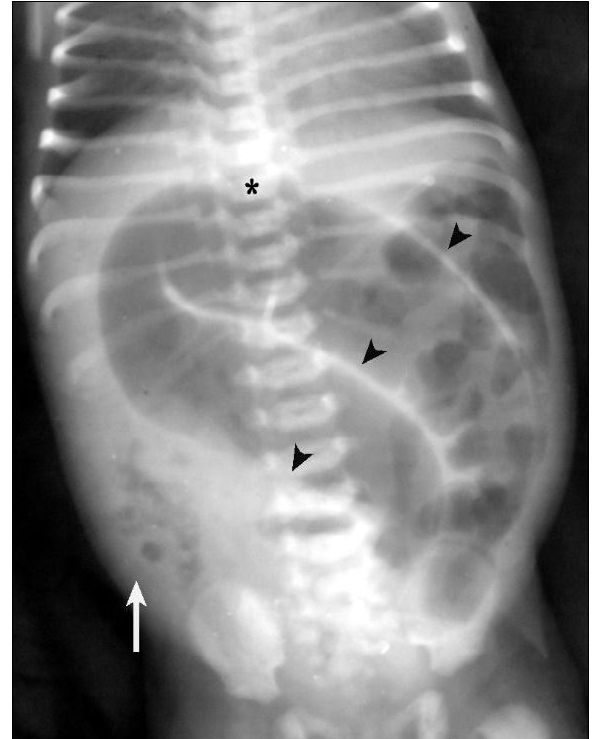
Figure 1: Plain radiograph showing Friemann- Dahl’s sign with converging lines towards the left iliac fossa (black arrowheads) and air bubbles (Neuhauser’s sign) in the right lower quadrant (white arrow). A black asterisk marks the D8